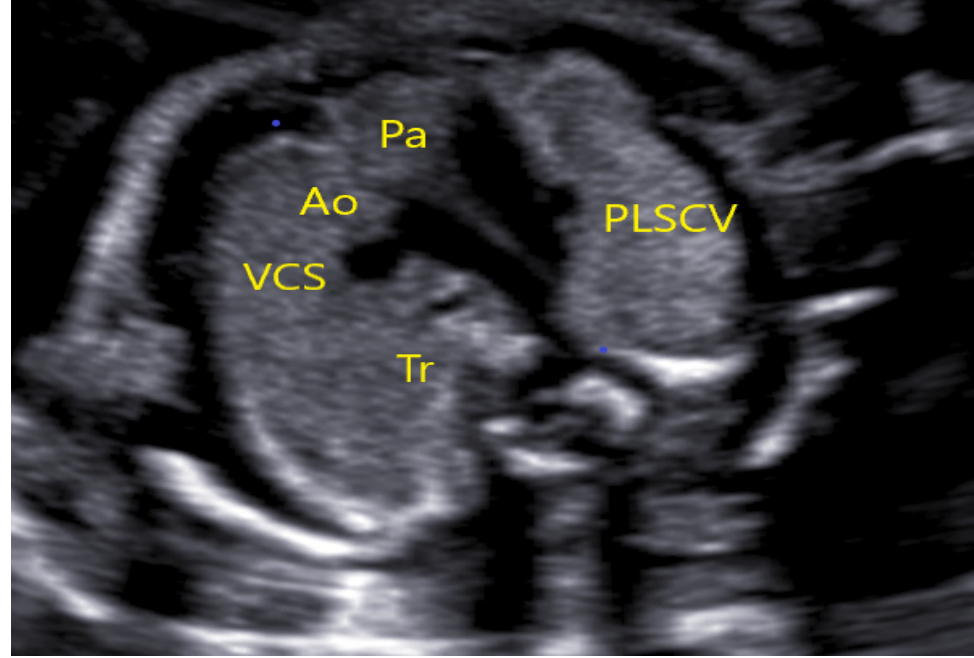
Figure 13. Case 4—TTVV with four vessels. (PLSVC—persistent left superior vena cava, Ao—Aorta, Pa—Pulmonary artery, VCS—Superior Vena Cava, Tr—Trachea).